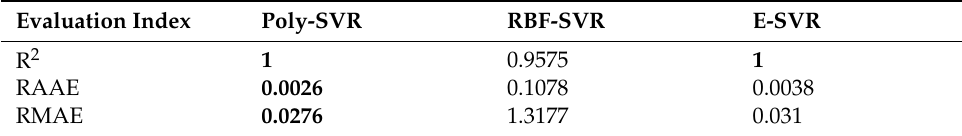
Figure 5. Three-dimensional graph of the Brain-Hoo function. Table 3. Brain-Hoo function test results.